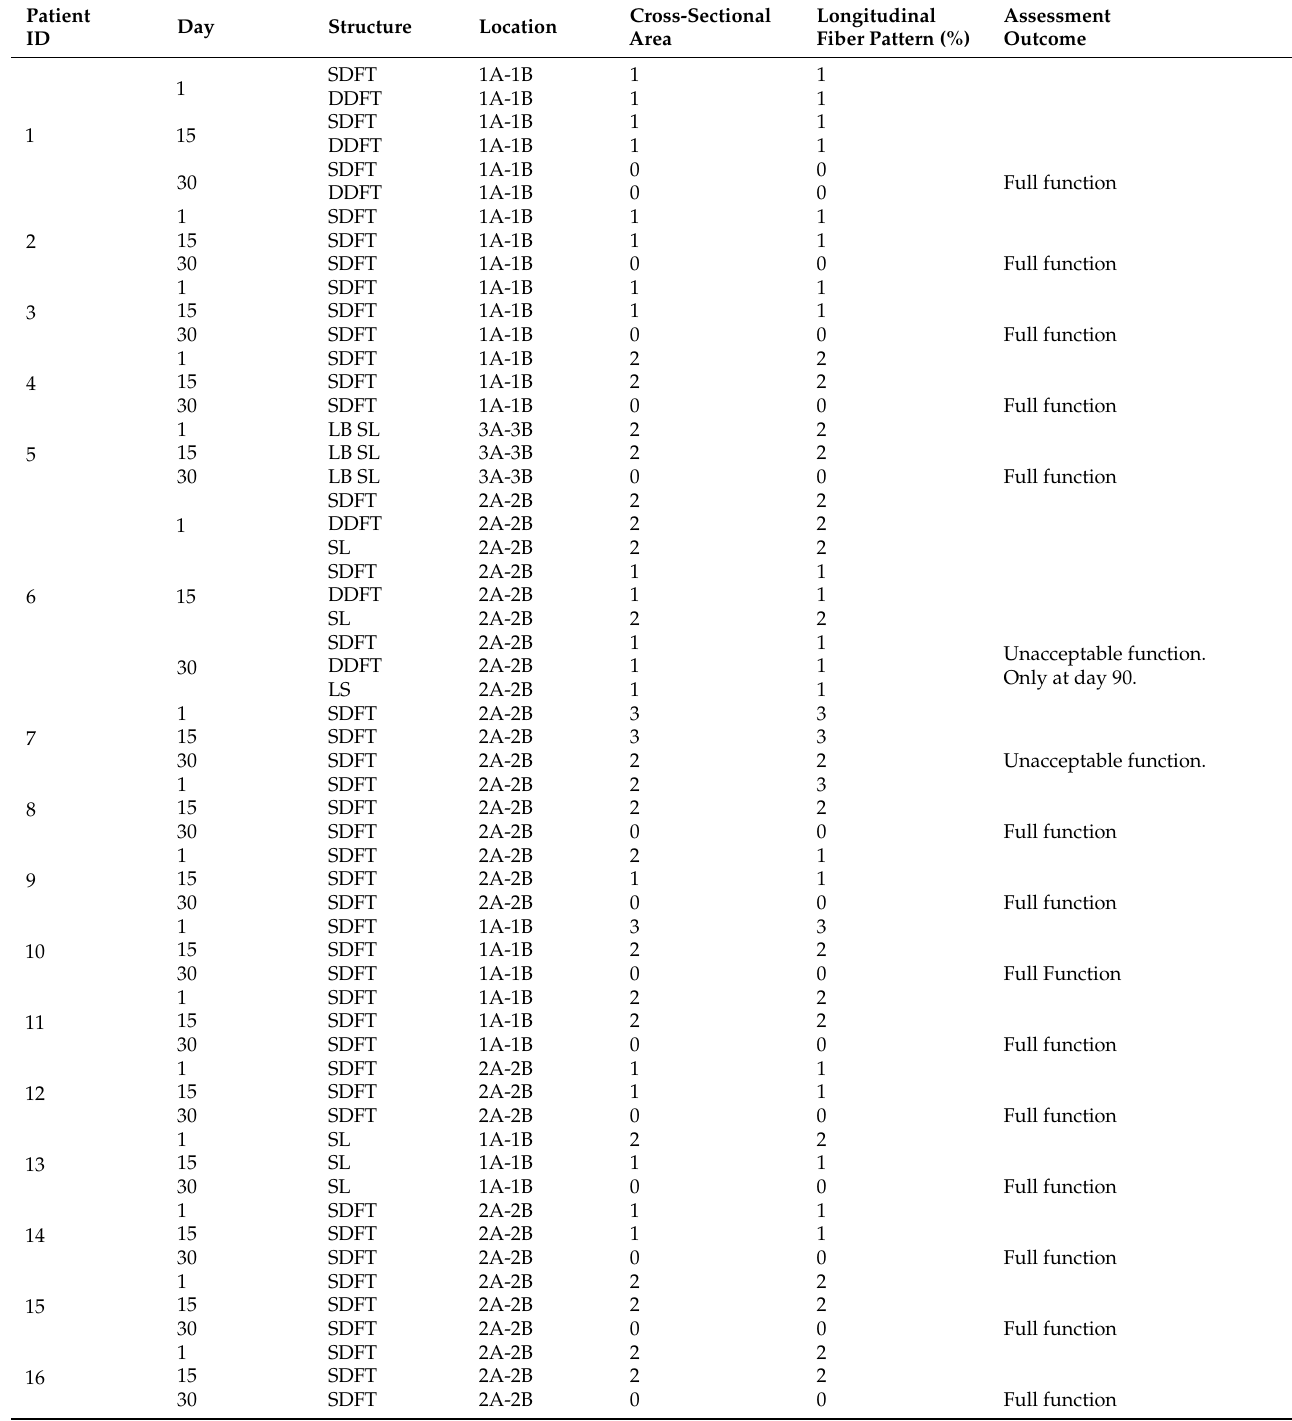
Table 7. Ultrasonographic lesion characterization at Days 1, 15, and 30. Equine patient identification, structure affected, lesion ultrasonographic location, cross-sectional area, and longitudinal fiber pattern are characterized. Assessment outcome is also evaluated. Affected structure superficial digital flexor tendon (SDFT), deep digital flexor tendon (DDFT), suspensory ligament (SL), and left branch (LB). Lesion ultrasonographic location (zones 1A-1B, 2A-2B, 3A-3B) [27], cross-sectional area % (0, 0%; 1, <25%; 2, >25–50%; 3, >50–75%; 4, >75%), longitudinal fiber pattern (0, 0%; 1, <25%; 2, >25–50%; 3, >50–75%; 4, >75%) [27], and assessment outcome (full function, acceptable function, and unacceptable function)